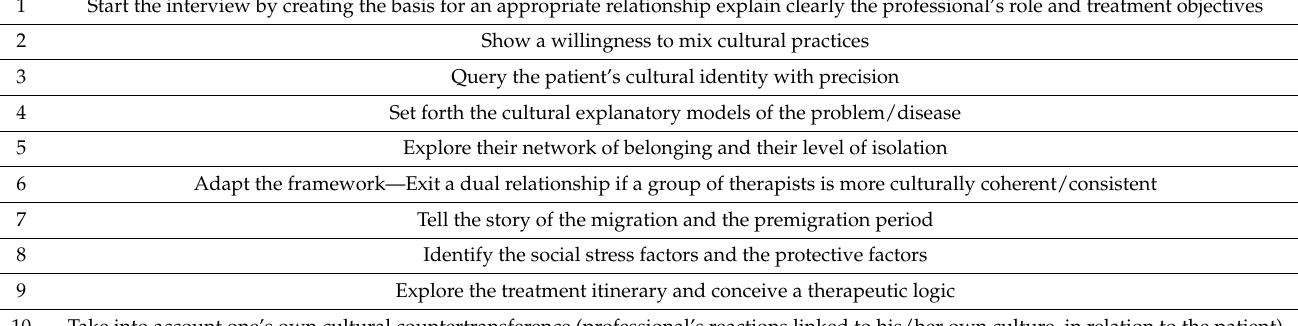
Table 1. Transcultural interview guide (From Radjack, et al., 2022